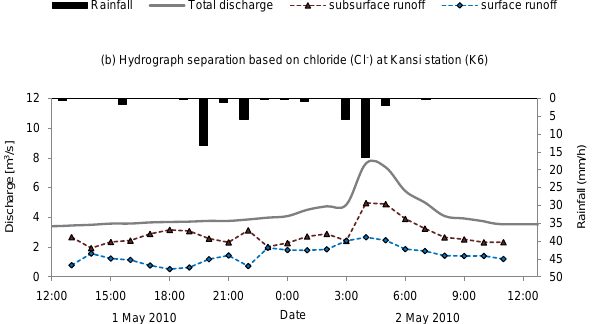
(b) Hydrograph separation based on chloride (Cl - ) at Kansi station (K6)